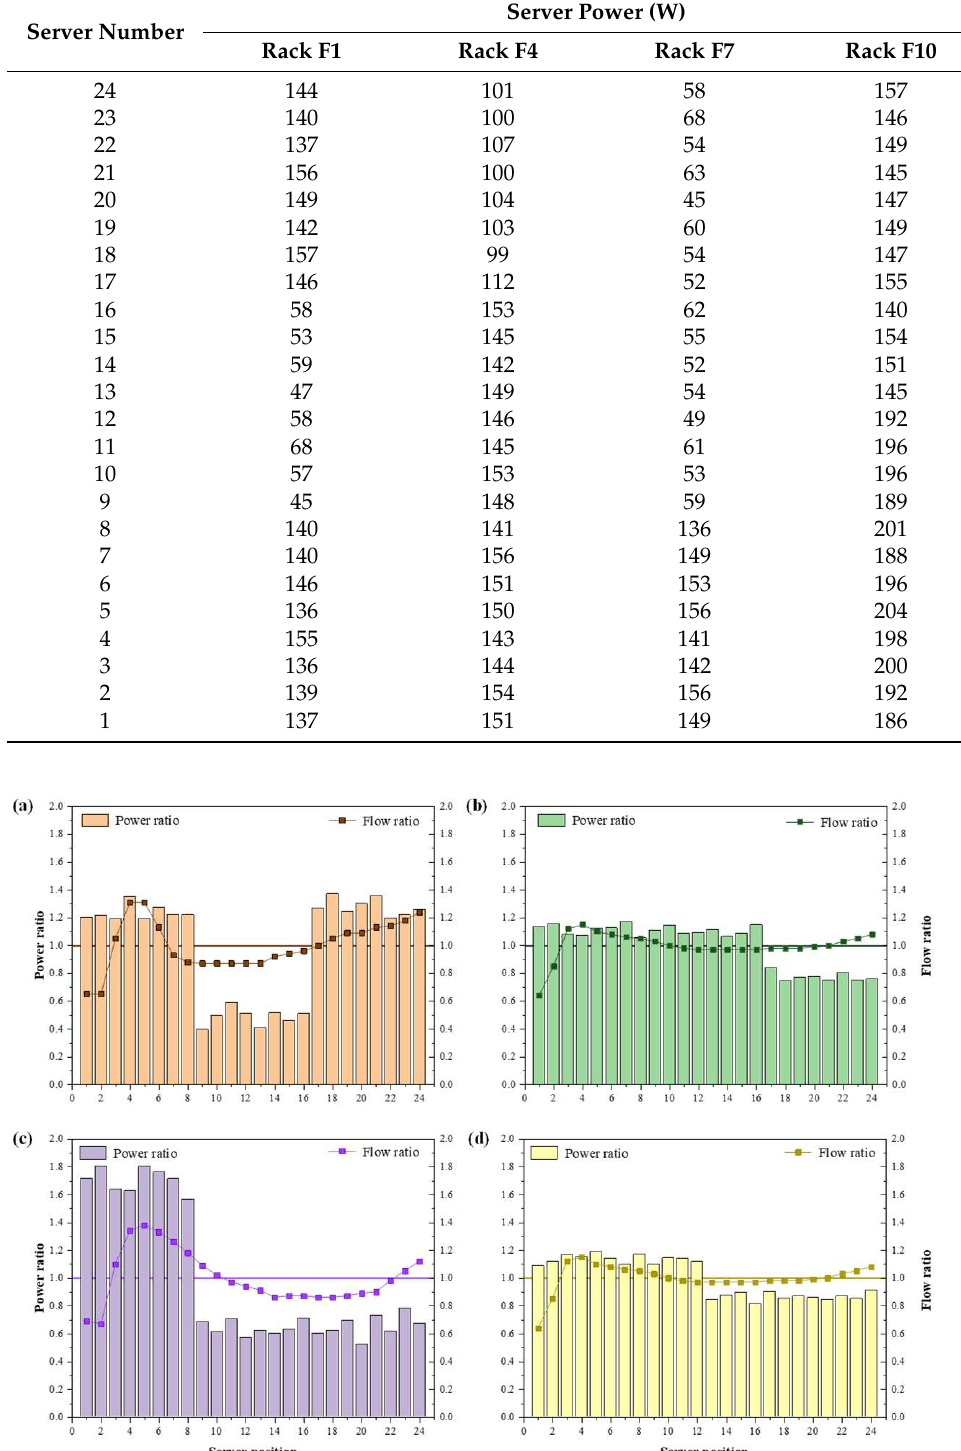
Table 1. Power distribution of Rack F1, F4, F7, and F10. Server Number